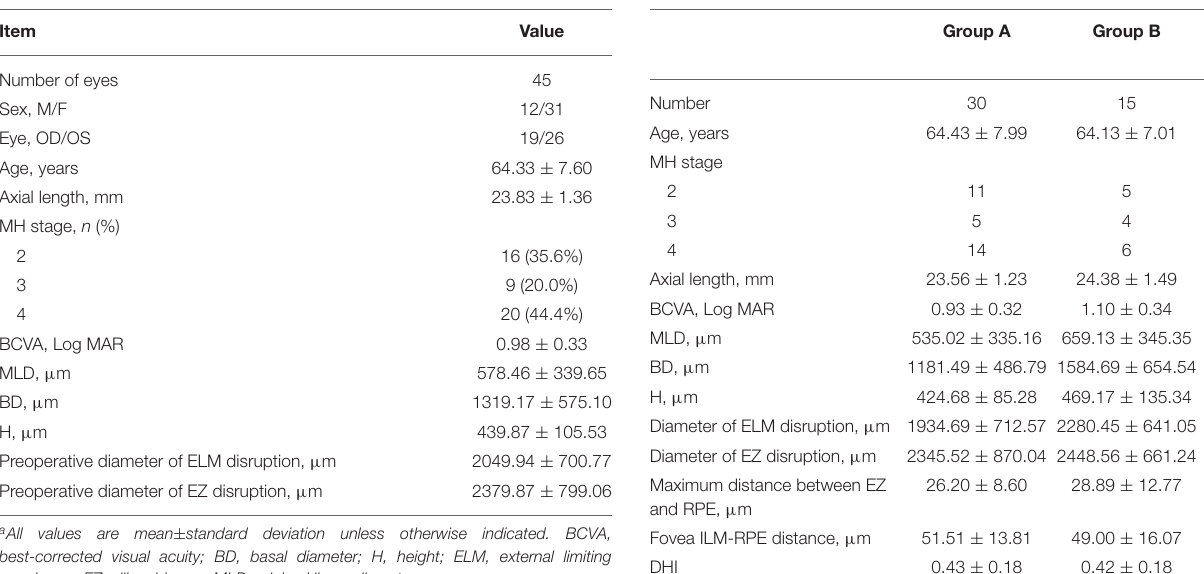
TABLE 1 | Demographic data a . TABLE 2 | Preoperative parameter comparisons between groups A and B a